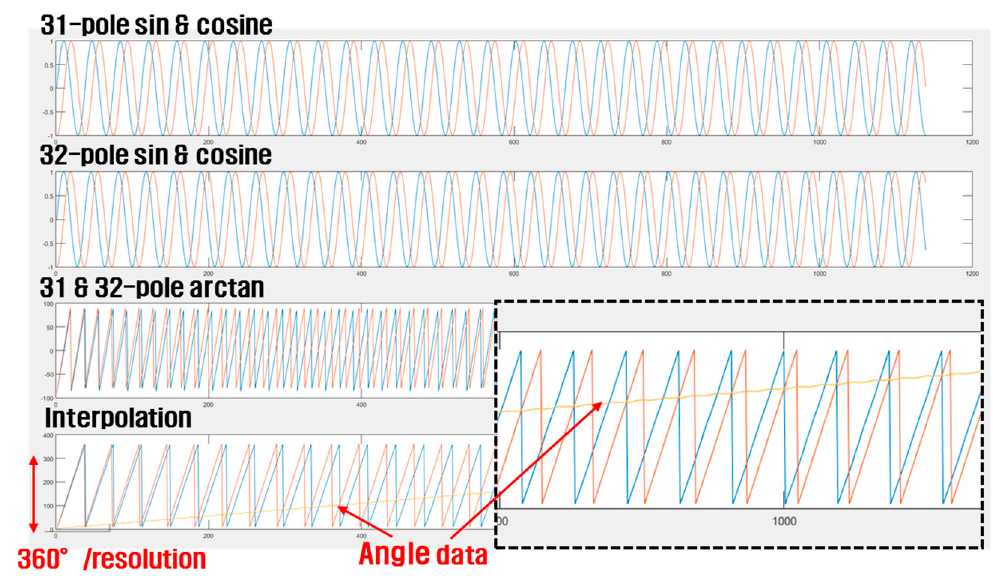
Figure 5. Results of angle detection simulation using MATLAB.